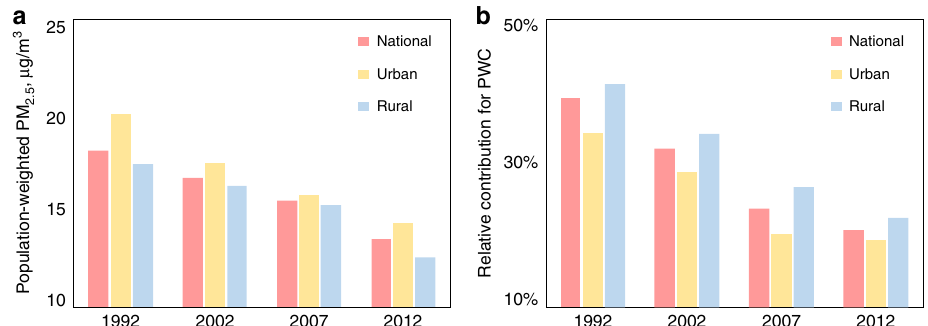
Fig. 1 Contributions of rural residential emissions to the overall population-weighted ambient PM 2.5 concentration (PWC) in mainland China from 1992 to 2012. The results are presented as the national total and for the rural and urban areas, in absolute a and relative b contributions, respectively. Source data are provided as a Source Data